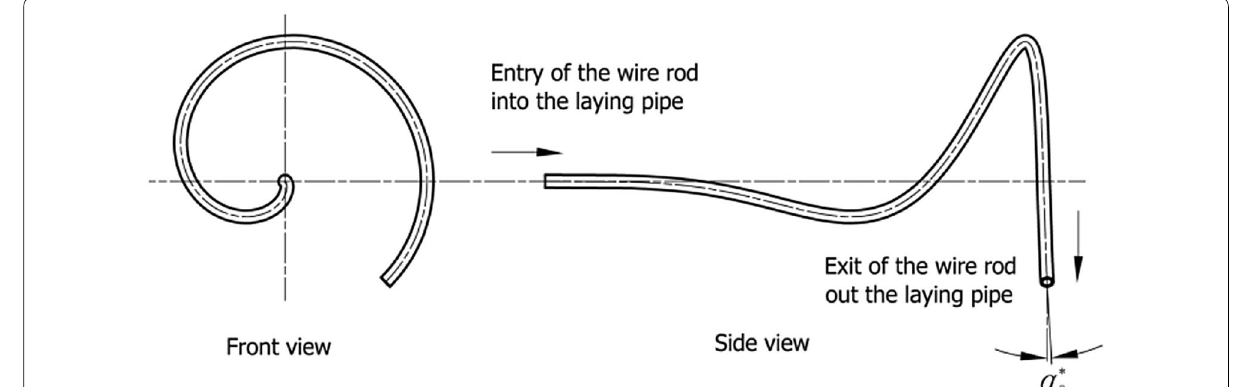
Figure 4 A diagram of a laying pipe